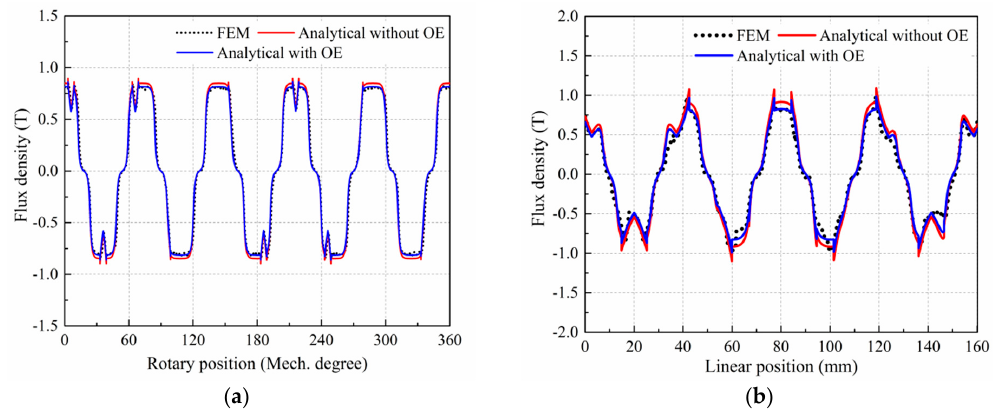
Figure 11. Radial flux density of the DSLRPMM. ( a ) Rotary motion unit; and ( b ) linear motion unit.